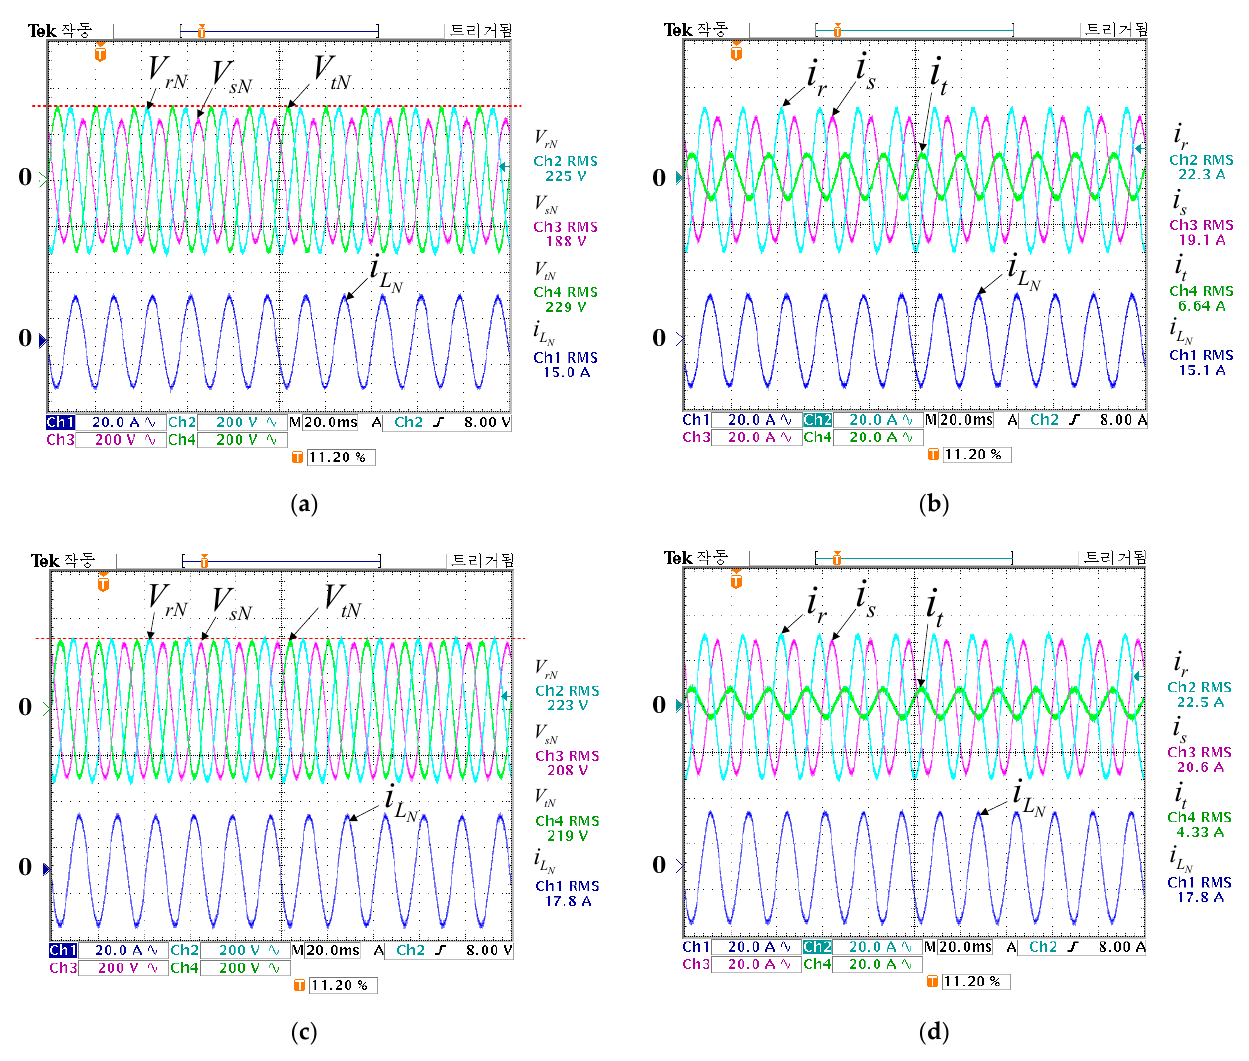
Figure 13. Experimental results that improve voltage imbalance through offset voltage ( V offset ) control when the inverter is in the independent operation mode, M a = 0.78 with V dc of 800 V and the reference command value of the inverter of 220 V: ( a ) phase voltage of each load and neutral line current in an unbalanced voltage condition; ( b ) phase current of each load under voltage imbalance conditions; ( c ) the voltage on each phase is balanced by subtracting the offset voltage from each phase voltage command of the inverter; ( d ) phase current of each load under voltage-balanced